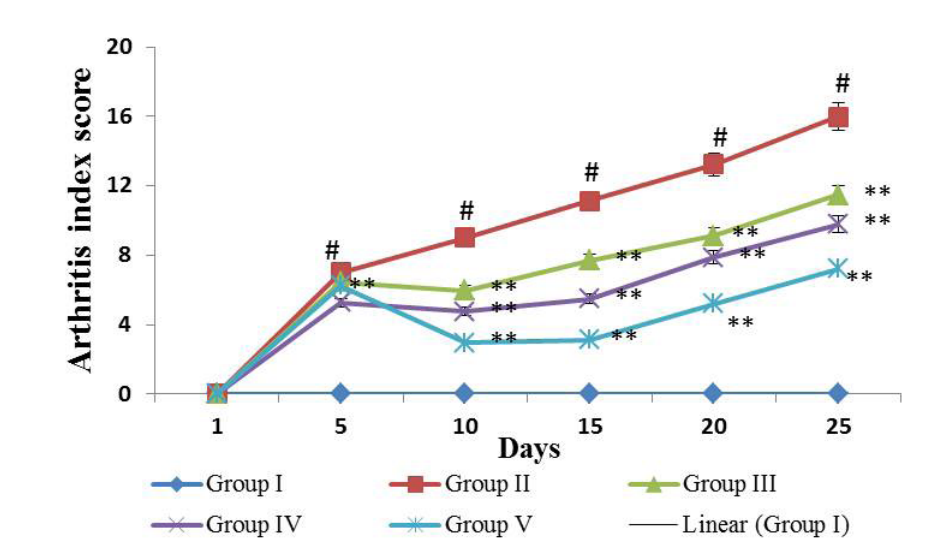
FIGURE 1 - Effect of ginkgolic acid on CFA induced osteoarthritis rats. (A) Effect on body weight; (B) Effect on organ indexes; (C) Effect on hind paw volume; (D) Effect on arthritis index score. Values expressed as mean ± SEM (n = 8) and analyzed by one-way ANOVA followed by Tukey’s multiple comparisons test. # p < 0.05 as compared to normal control group I. ** p < 0.01 as compared to CFA group II.